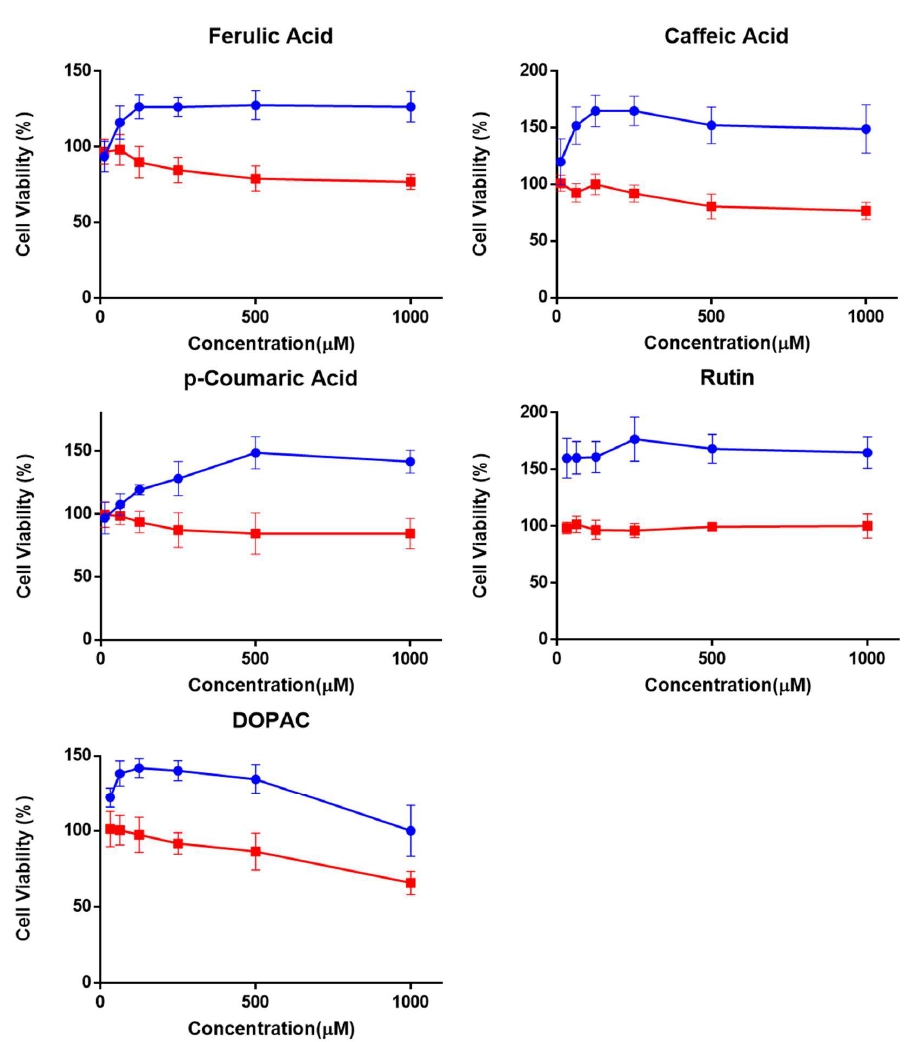
Figure 3 . Cell viability of HaCaT cells exposed to the tested compounds assessed using the Neutral Red assay. ( ▬ ) Irr-: Non-irradiated; ( ▬ ) Irr+: Irradiated plate. Data are presented as mean ± SD (n = 3) relative to solvent control.